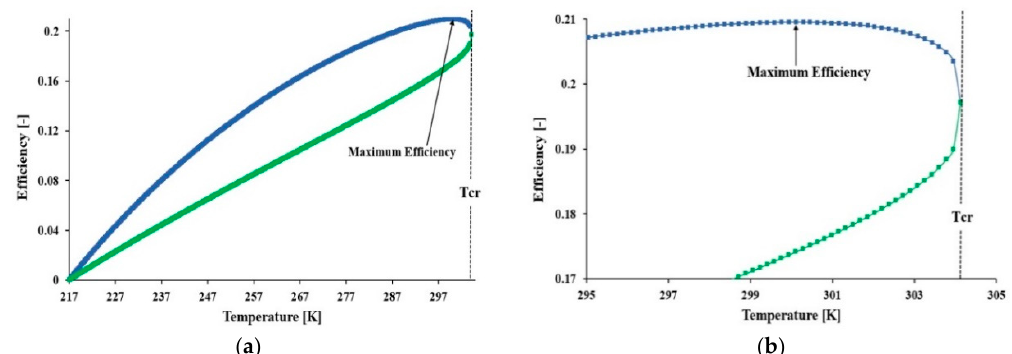
Figure 4. The efficiency of a CO 2 Rankine-like Power Cycle (upper lines) and Trilateral Flash Cycle (lower lines) with fixed condenser temperature (216.6 K) and with increasing evaporator temperature. ( a ) full temperature range; ( b ) the vicinity of the critical temperature.